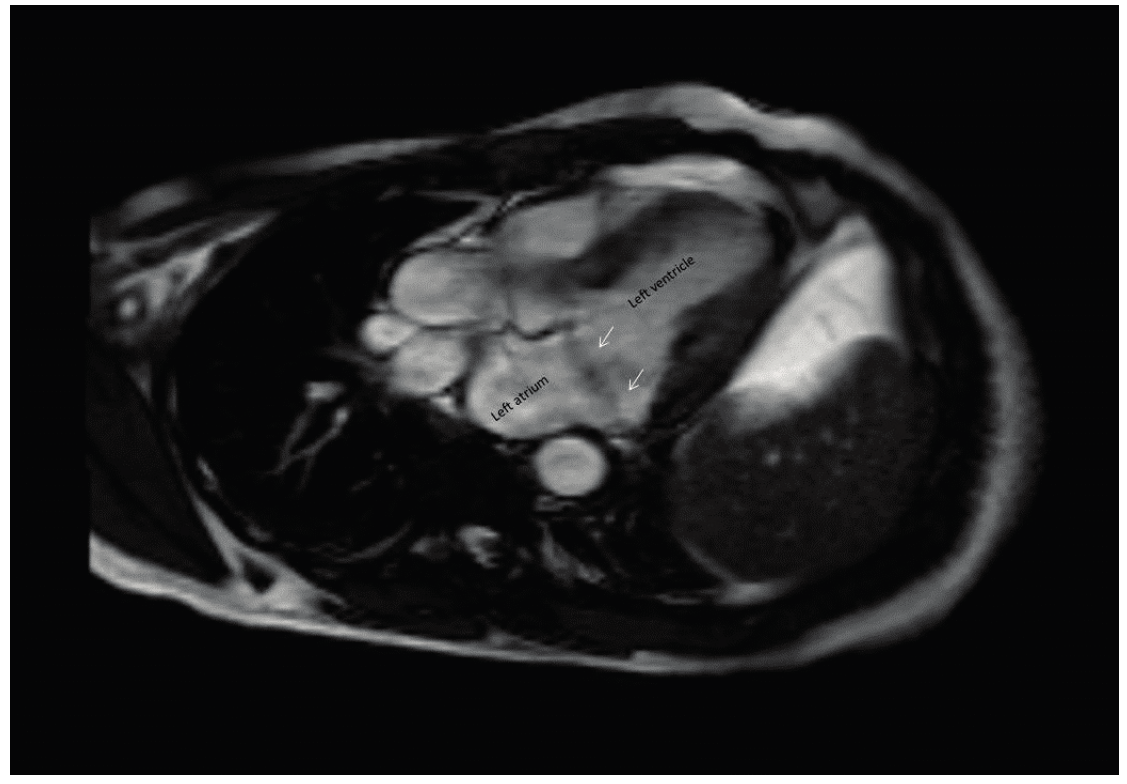
Figure 3. A steady state free precession image on parasternal long axis view of the mitral valve. Note the atrial displacement of both leaflets